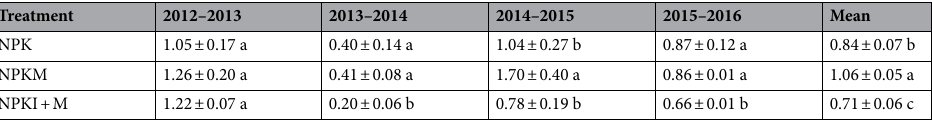
Table 2. Annual cumulative fluxes of N 2 O (kg N ha −1 ) under different treatments through the experimental period (2012–2015). Mean ± standard deviation (n = 3). Different lowercase letters in one column indicate significant difference among treatments ( p < 0.05).